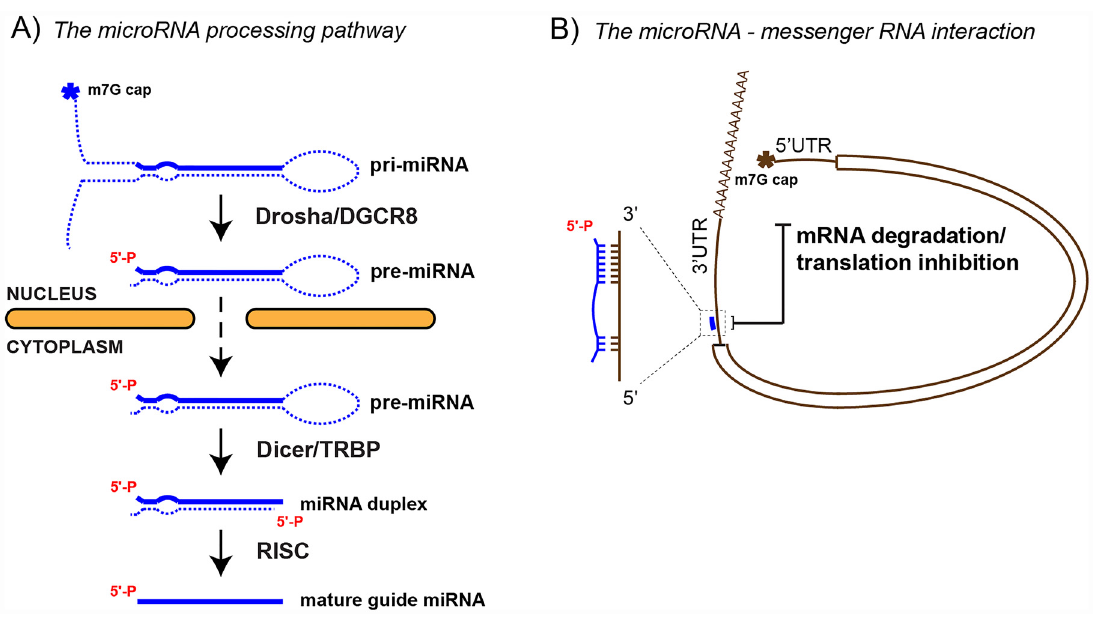
Fig 1. Simplified schematic of (A) the miRNA biogenesis pathway and (B) the interaction between the mRNA and miRNA. (A) The primary miRNA precursor (pri-miRNA) is synthesized by RNAP II. The pri-miRNA is first cleaved by Drosha to release a hairpin loop – shaped RNA called pre-miRNA. The loop of this pre-miRNA is further cleaved by Dicer to generate a miRNA duplex. The miRNA duplex is dissociated and the passenger strand (dashed line) is discarded while the guide strand is loaded onto the Argonaute protein to form an active RISC complex. (B) Example of miRNA – target mRNA interaction by base- pairing mainly at the seed region of miRNA (nt 2 – 8) but also on other downstream regions of the miRNA. In the mRNA, the coding region is represented as a double line. N.B. The asterisks indicate the m7G cap (7-methyl-guanosine with 5 0 , 5 0 - triphosphate